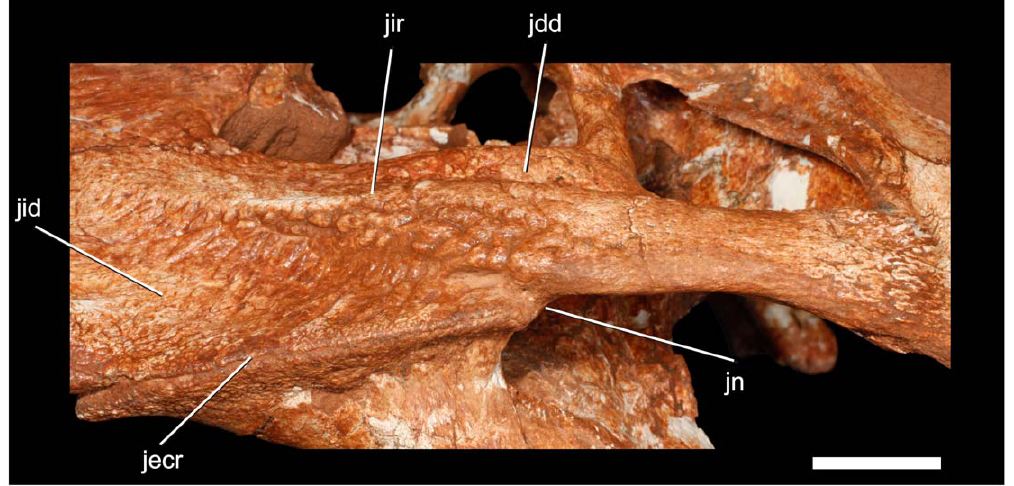
Figure 10. Details of the left cheek area of Pissarrachampsasera (LPRP/USP 0018). Abbreviations: jecr, jugal-ectopterygoid ridged suture; jid, jugal infraorbital depression; jn, jugal notch. Scale bar equals 1 cm.